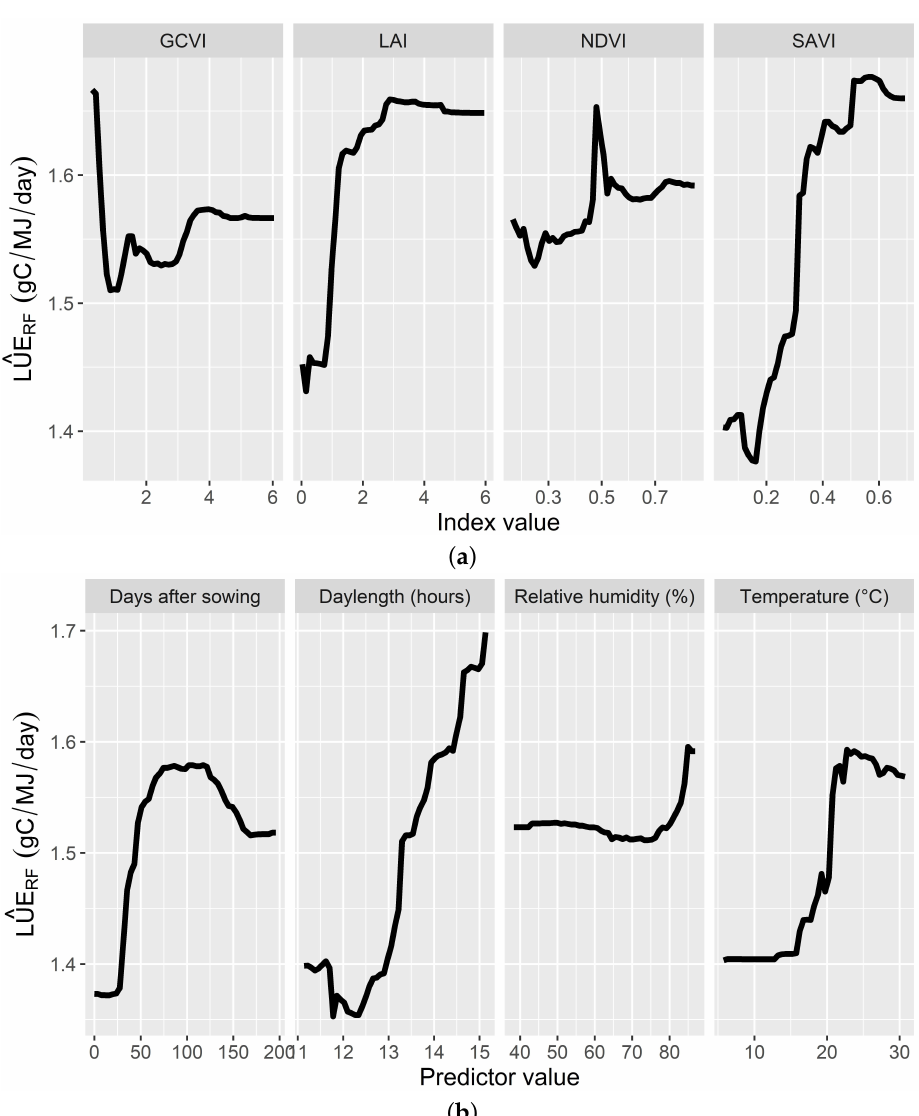
Figure 6. Partial dependence of light use efficiency predictions on ( a ) vegetation index and ( b ) agroclimatic predictors in the random forest regression model fit with all variables in Table 3 as